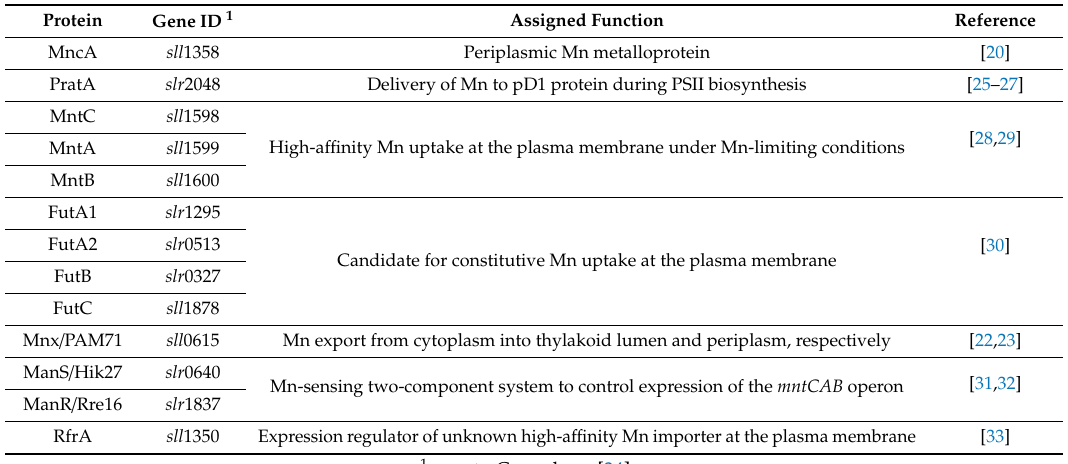
Table 1. List of proteins assigned to function in the Mn homeostasis network in Synechocystis . Protein Gene ID 1 Assigned